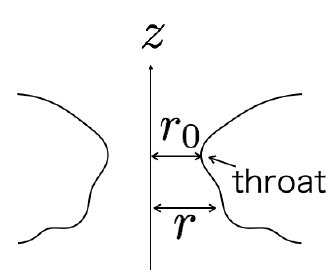
Figure 6. The embedding of the Morris–Thorne type metric. In general, wormholes do not have a mirror symmetry (such as the Einstein–Rosen bridge) as long as the flaring out condition is